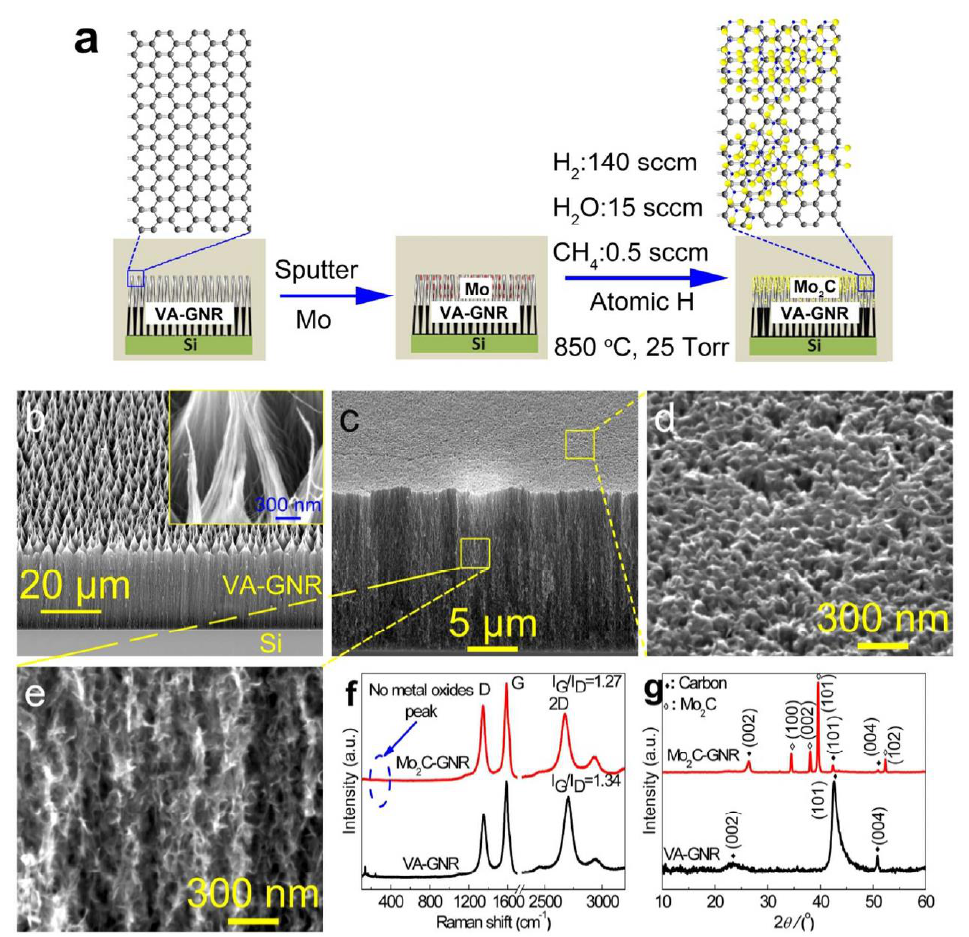
Figure 4. ( a ) Schematic showing the formation of Mo 2 C over VA-GNR, ( b – e ) field-emission SEM image of VA-GNR and Mo 2 C-GNR at high and low magnifications, ( f , g ) their corresponding Raman spectra in the range of 300 – 3100 cm − 1 and XRD patterns in the 2 θ range of 10°-60°. These spectral analyses confirmed the formation of Mo 2 C over the GNR matrix [43] . Copyright 2017 The American Chemical Society.